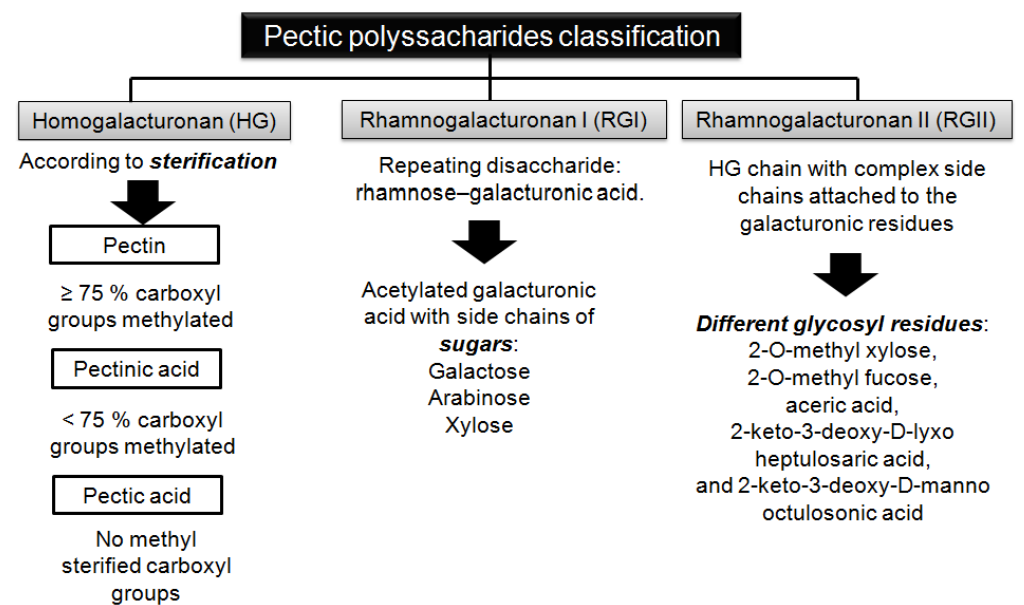
Figure 1. Classification of pectic polyssacharides based on D -galacturonic acid